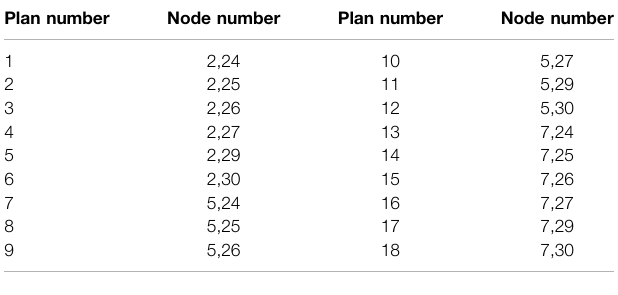
TABLE 1 | Placement plan obtained by traditional method. Plan number